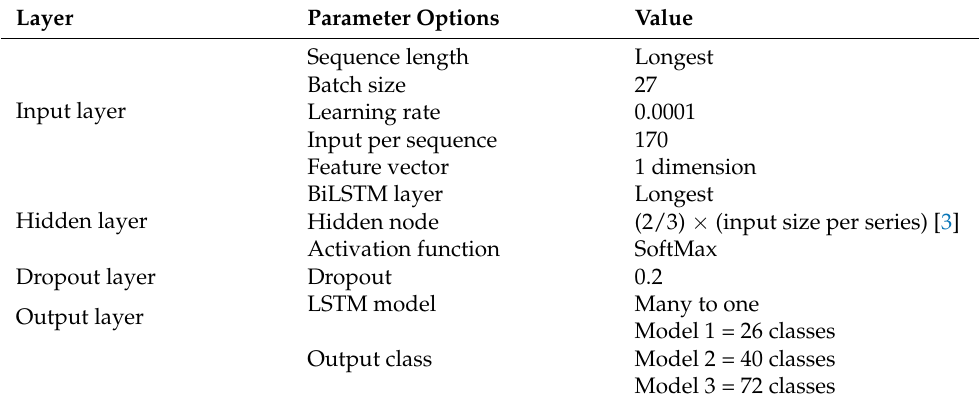
Table 4. Classification parameter settings for the two-layer BiLSTM neural